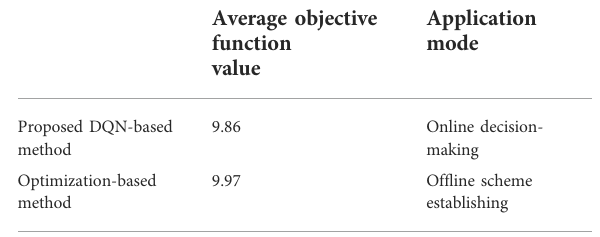
TABLE 5 Comparison with the optimization-based